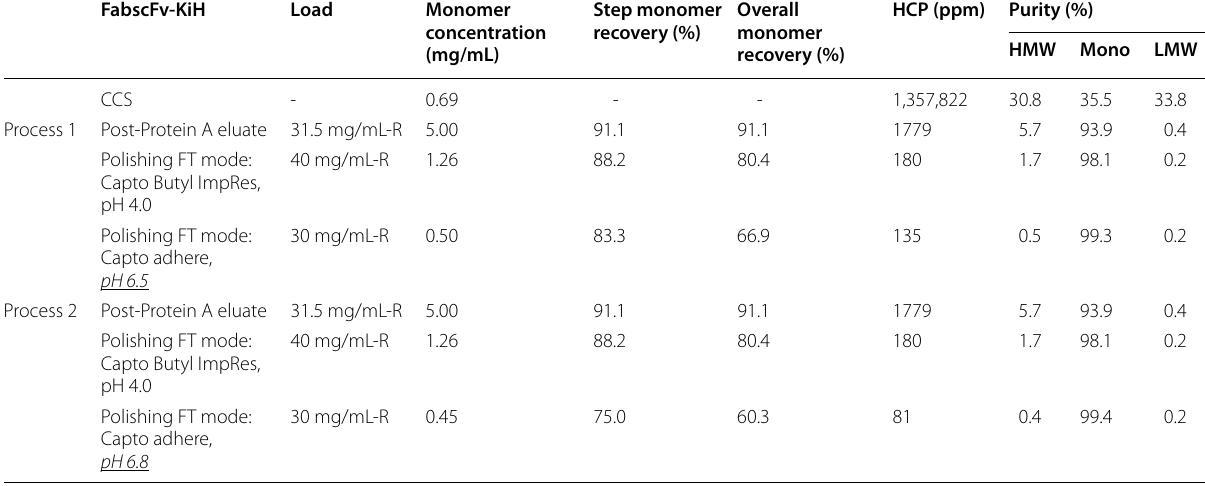
Table 5 Comparison between the effect of pH 6.5 and pH 6.8 on Capto adhere flow-through mode using FabscFv-KiH FabscFv‑KiH Load Monomer